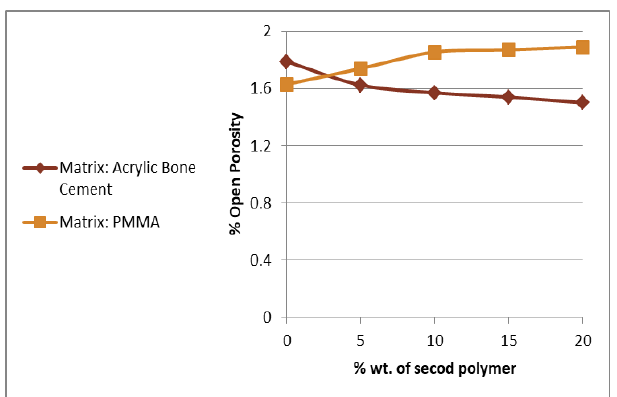
Figure, 4: Open porosity of (Acrylic bone cement: % X PMMA), and (PMMA: % X Acrylic bone cement) as a function of a second material content in blend